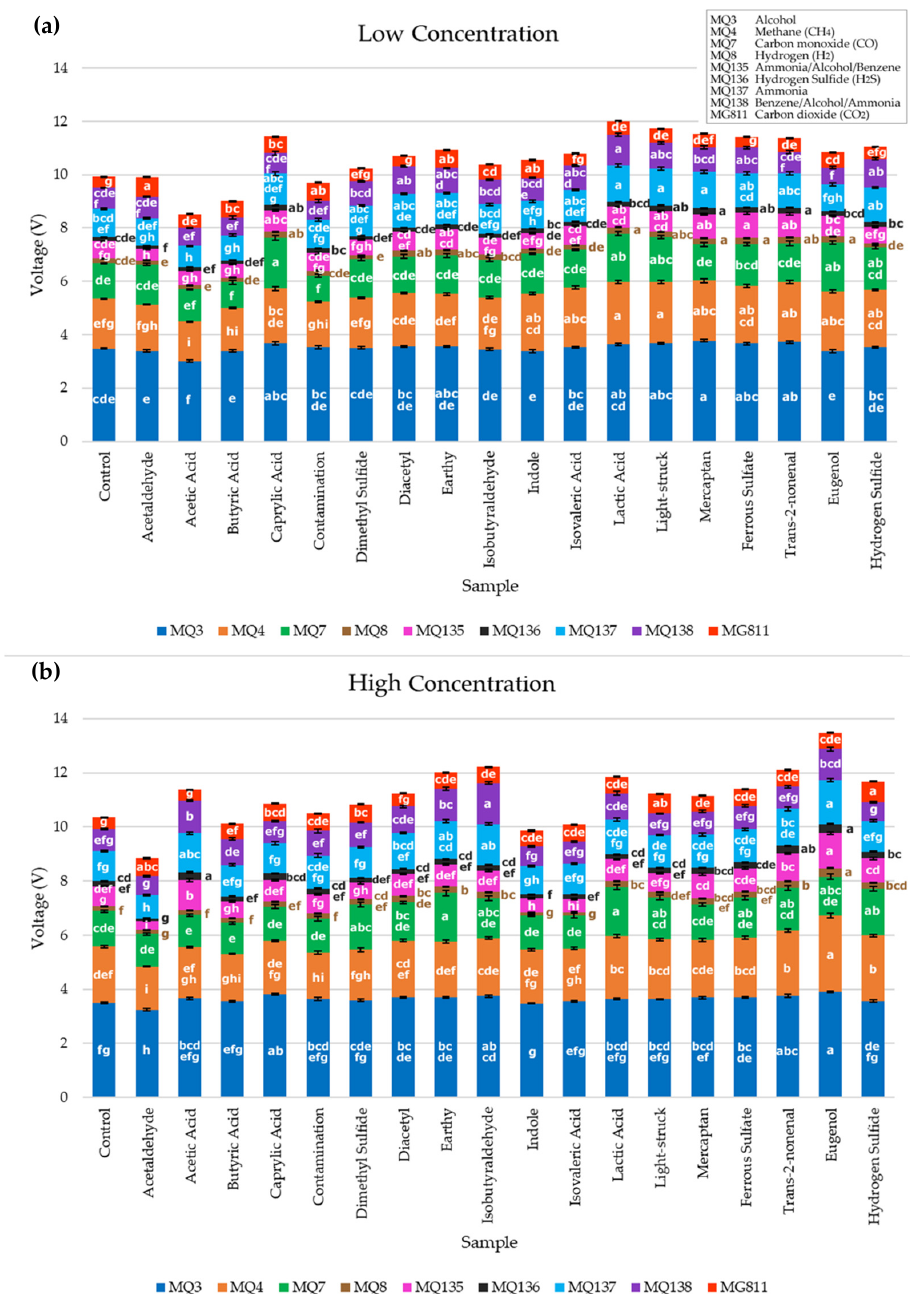
Figure 4. Stacked bar graphs for ( a ) low and ( b ) high concentrations showing the mean voltage values obtained from the electronic nose sensors. Error bars are based on standard error. Different letters depict significant differences (p < 0.05) between samples for each sensor based on the Tukey honest significant difference (HSD) post-hoc test.